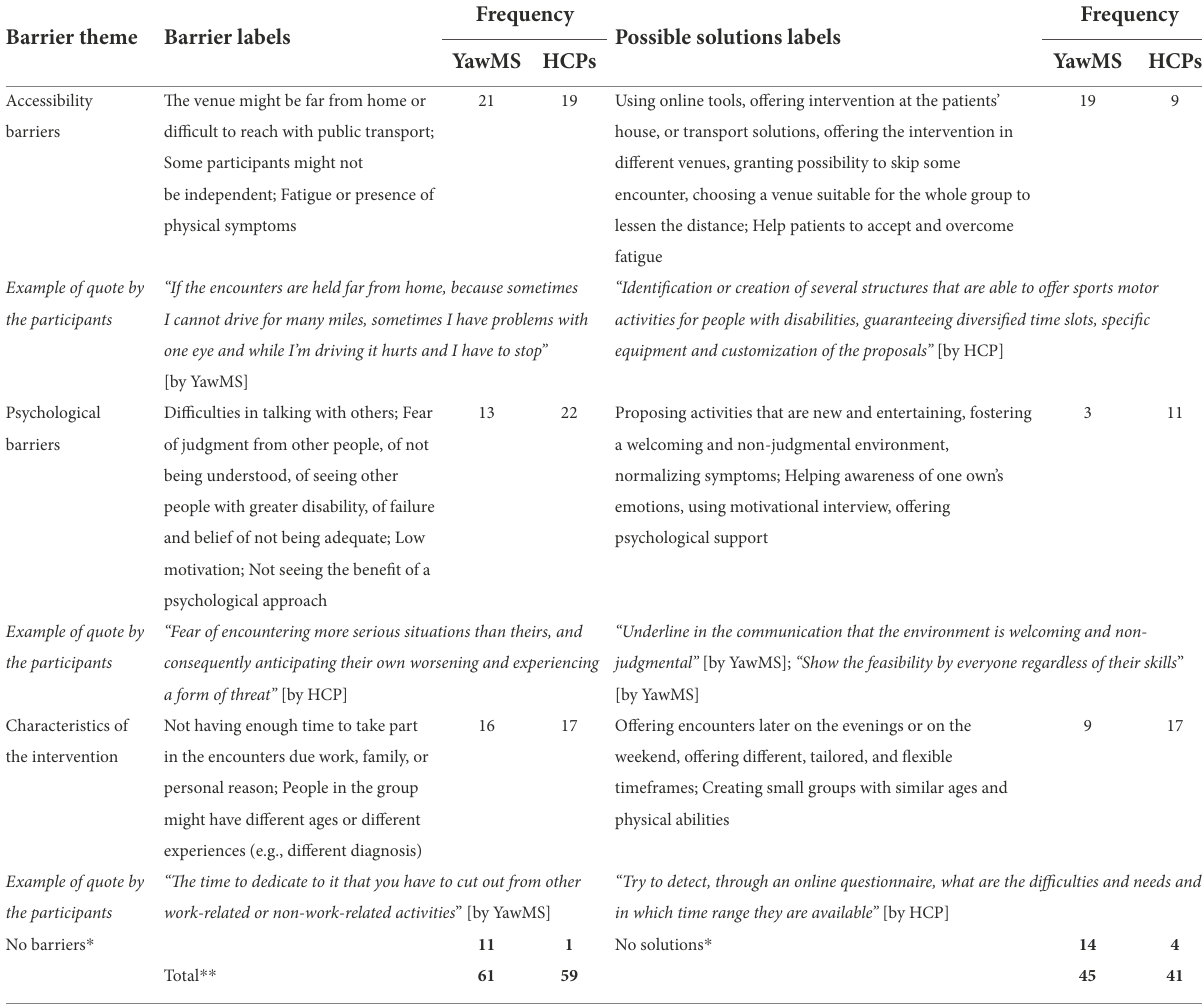
TABLE 5 Survey with YawMS ( N = 121) and with HCPs ( N = 43): qualitative analysis of barriers for patients to participate in the intervention and possible solutions.